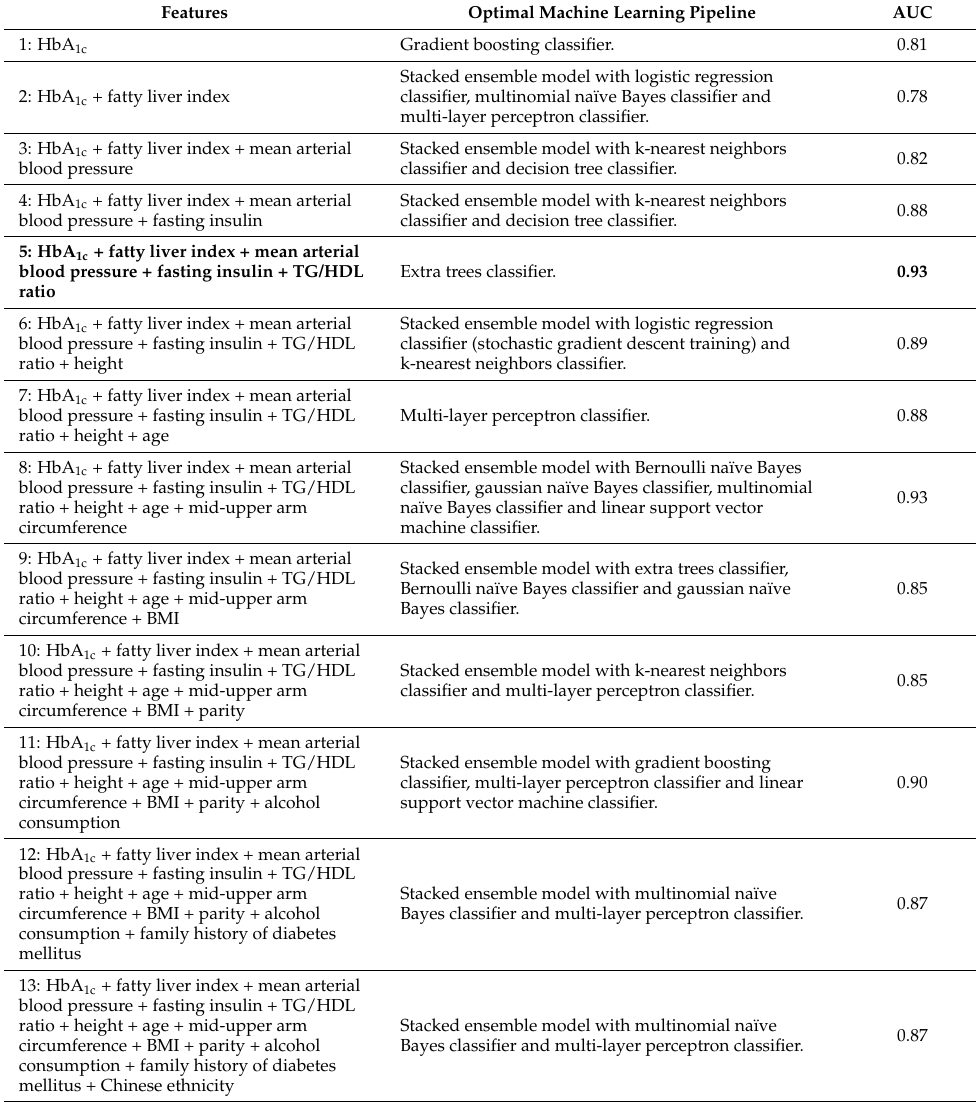
Table 2. Construction of preconception predictive risk model. The preconception predictive risk model for GDM was sequentially constructed using top predictors with SHAP value magnitudes greater than zero in the AutoML feature selection model. The optimal machine learning pipeline for each model and area under the receiver operating characteristic curve (AUC) performance metric are reported. The proposed AutoML model was also robust when replacing HbA 1c with fasting glucose (AUC: 0.87), replacing mean arterial blood pressure with systolic blood pressure (AUC: 0.91) and replacing fasting insulin with HOMA-IR index (AUC: 0.91) (Supplementary Table S1). HbA 1c had the greatest impact on model performance changes ( ∆ AUC = − 0.06), followed by mean arterial blood pressure ( ∆ AUC = − 0.02) and fasting insulin ( ∆ AUC = − 0.02). Given these observations, maternal insulin resistance around conception can be postulated as an important determinant in the pathophysiology of metabolic diseases and fetal